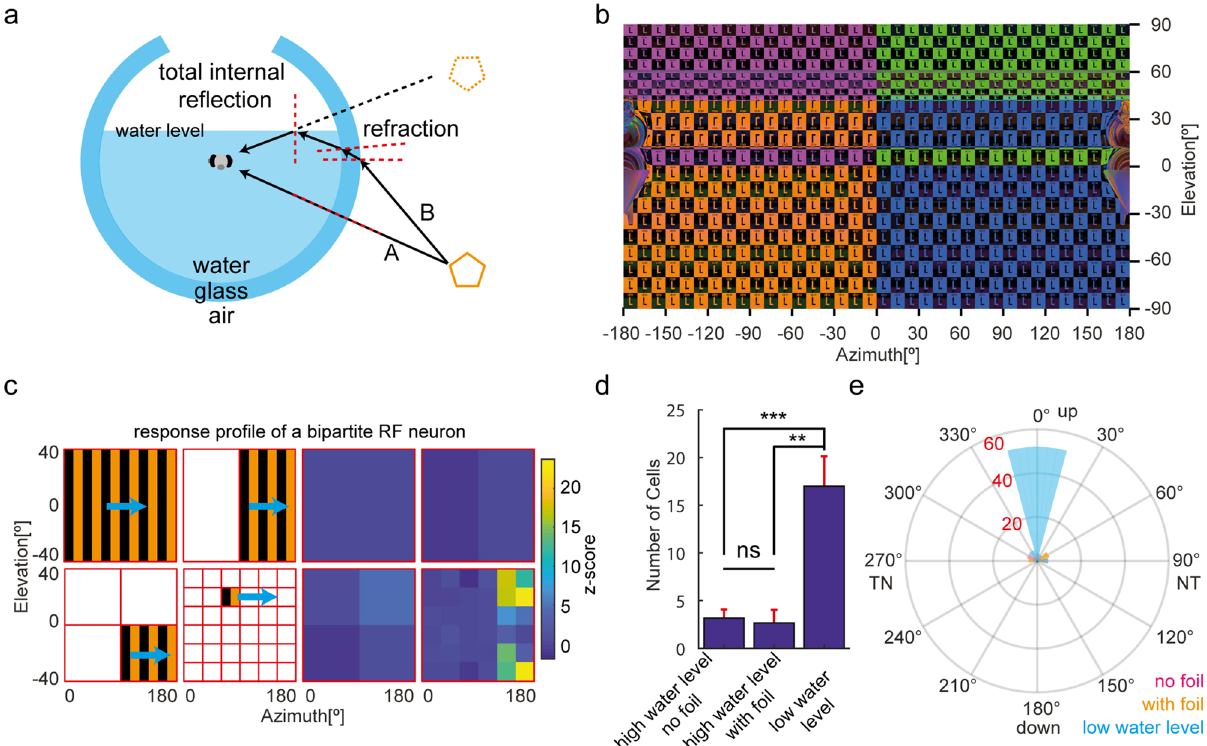
Figure 2. TIR results in the erroneous detection of bipartite receptive fields in the zebrafish optic tectum. ( a ) Illustration of TIR for the glass bulb with low water levels. Light beam A is perpendicular to the air-glass- water interface and reaches the fish right eye directly. However, light beam B, from the same light source as light beam A, is refracted twice on the air-glass-water interfaces and then reaches the fish’s eye from above via TIR. Black arrows, light beams; dashed red lines, perpendiculars; orange pentagon, one object; dashed orange pentagon, reflection of the object. ( b ) A 360° panorama picture of the stimulus pattern seen from the glass bulb center with low water level. Part of the visual stimulus below the equator is reflected to the upper visual field (the upside-down letters "L" in orange and blue) via TIR. ( c ) The response profile of a bipartite RF neuron. Left side: a diagram of the monocular RF mapping protocol (Supplementary Figure S3 shows the whole protocol). Horizontally moving gratings (indicated by cyan arrows) of different sizes and locations were sequentially presented to the right eye of the animal. Right side: z-scores of the calcium signal of a bipartite RF neuron responding to motion phases on the left. The neuron responded exclusively to small-size motion. Two separate RF centers are present in the same neurons and located in the upper and lower temporal visual fields, respectively. ( d ) The average numbers of bipartite RF neurons in each tested fish measured under different experimental conditions. ***, p < 0.001; **, p < 0.01; ns, no significant differences. The “high water level” group was further split into two subgroups (cf. Figure 3) for which the left eye was either occluded (“with foil”) or left free to see potential contralateral reflections (“no foil”) ( e ) A polar histogram of the orientation of the two RF centers for each neuron. Orientations of 0° and 180° correspond to a vertical orientation, 90° and 270° to a horizontal orientation of the bipartite RF centers. TN, temporal-nasal direction; NT, nasal-temporal direction. Neuron numbers are indicated in red. n = 6 (3 composite fish brains, high water level no foil), 6 (3 composite fish brains, high water level with foil) and 4 (2 composite fish brain, low water level) recordings in ( d ) and ( e